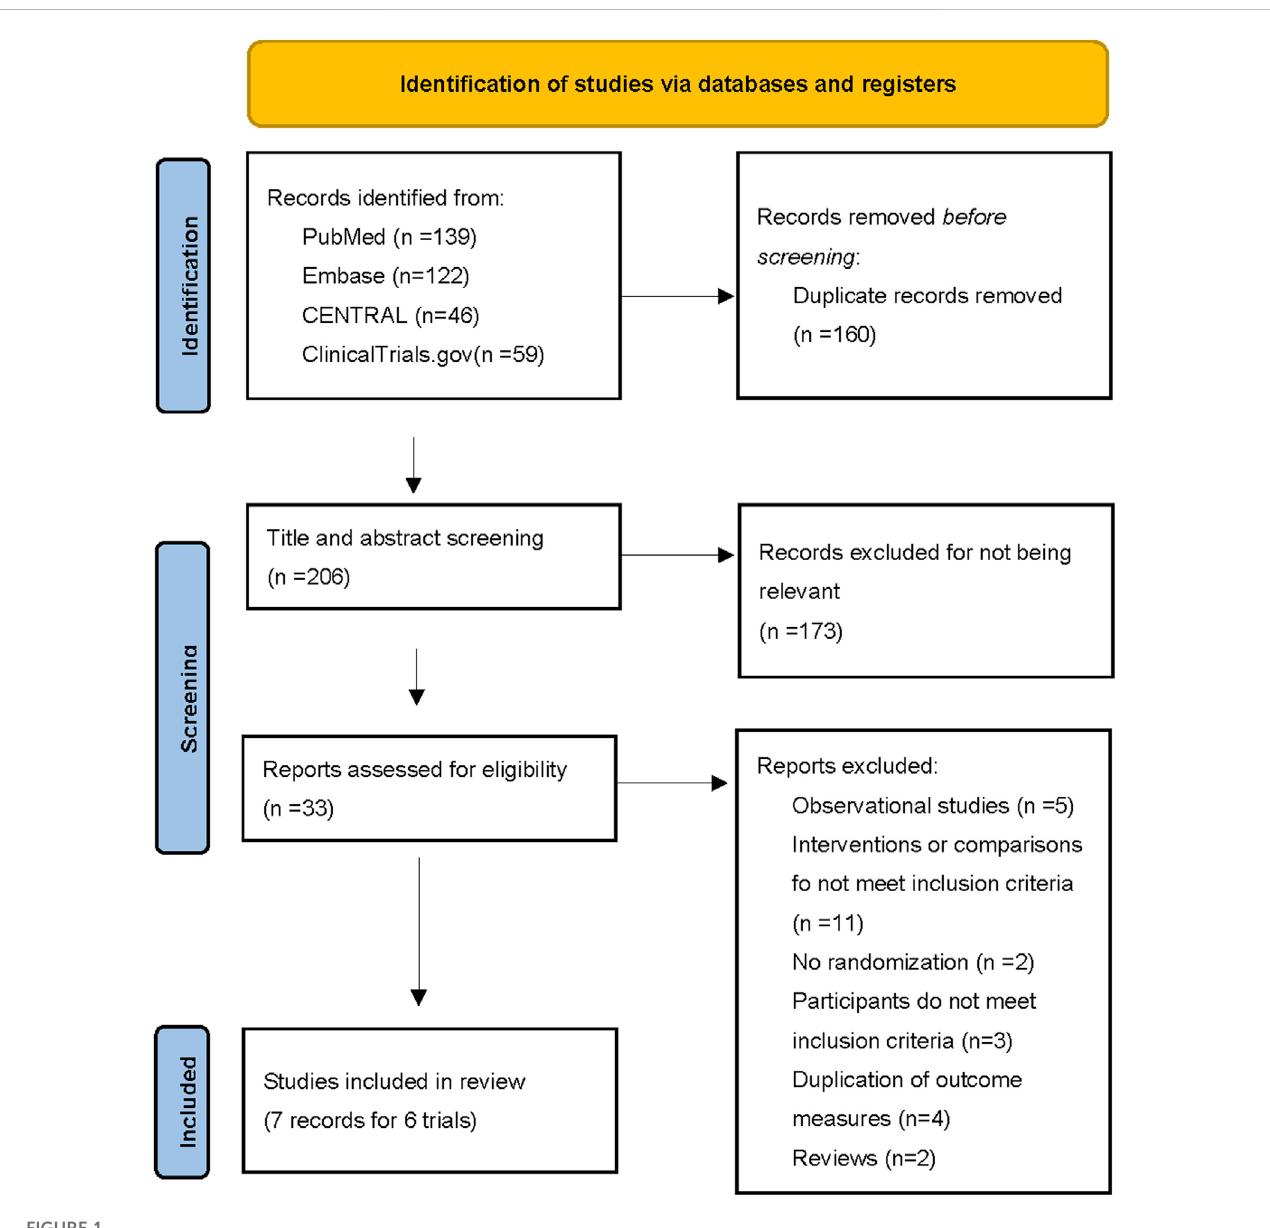
FIGURE 1 Flow diagram of literature search and